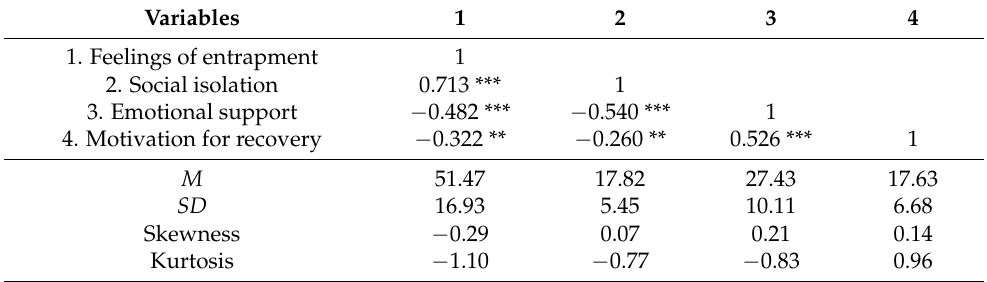
Table 2. Correlational matrix of entrapment, social isolation, emotional support, and motivation for recovery of alcoholic patients ( N =